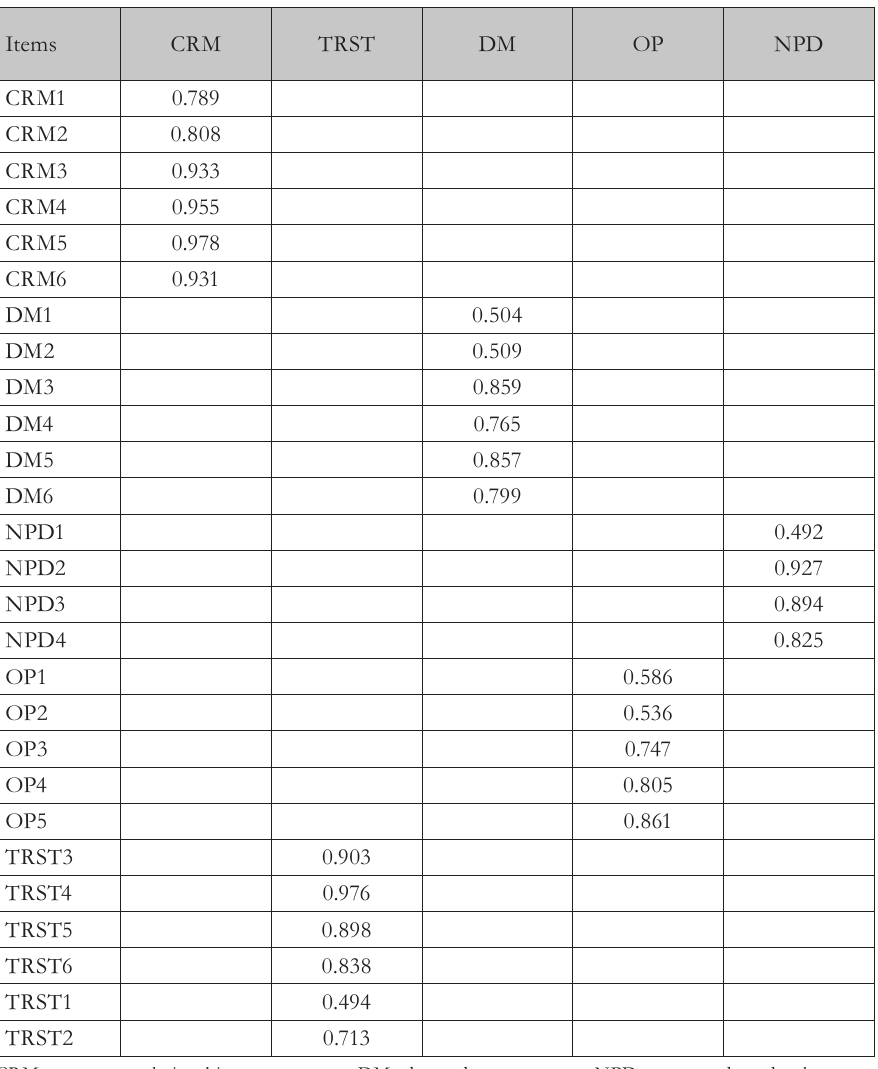
Tab. 2 – Exploratory factor analysis (EFA) (Source: